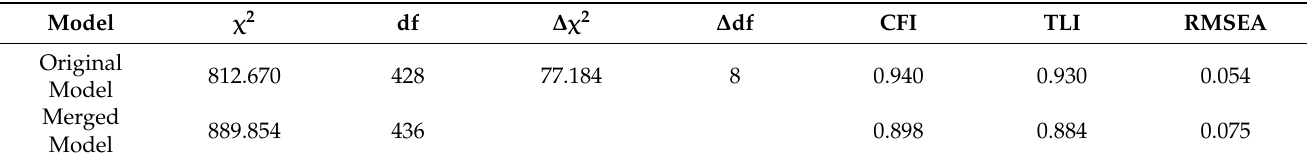
Table 5. Discriminant analysis results.